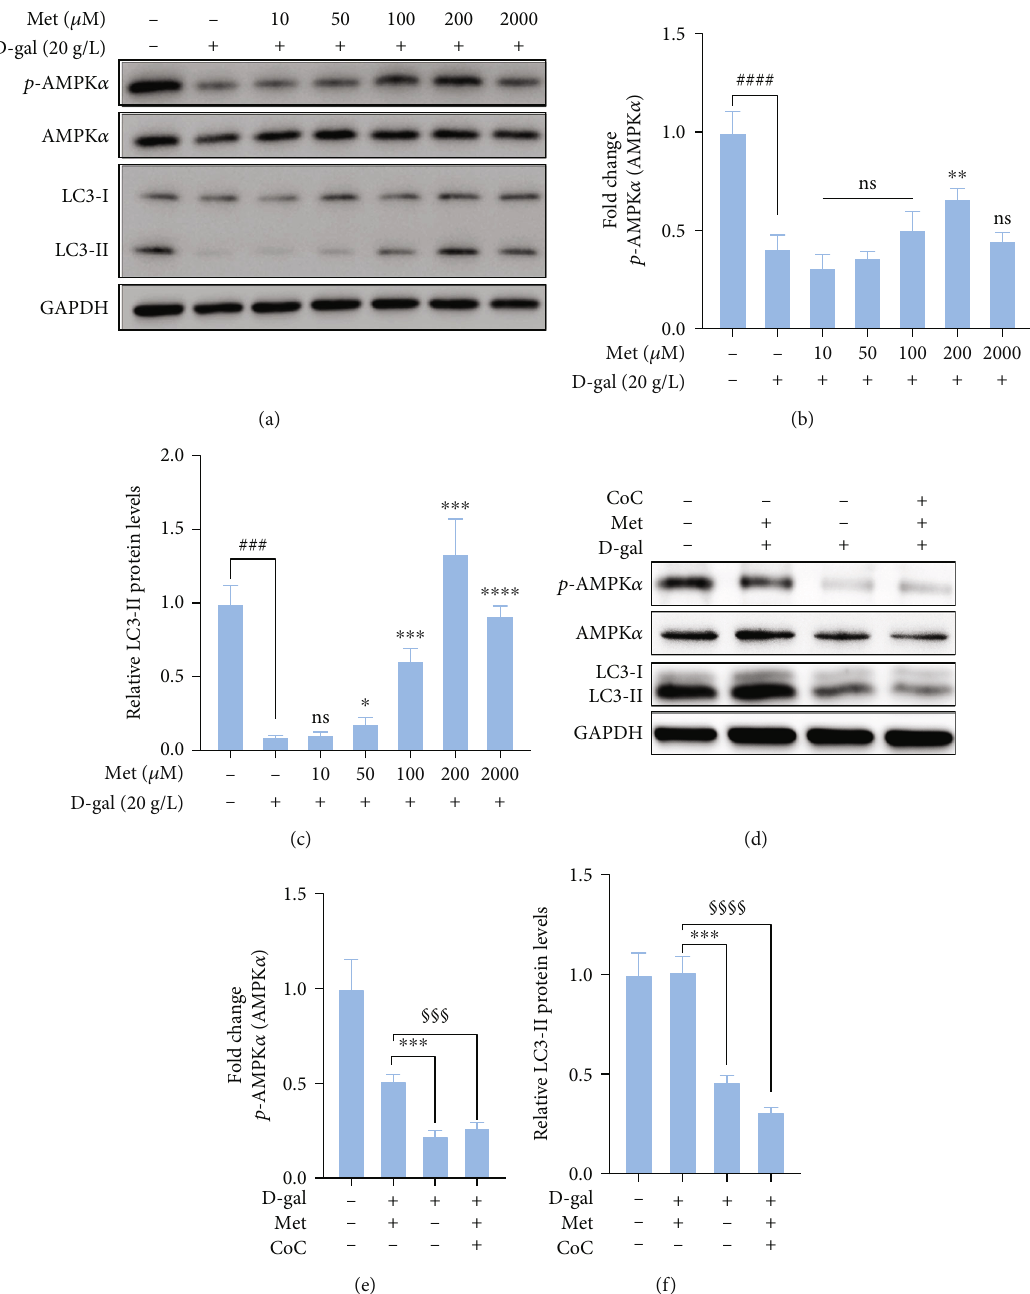
Figure 4: Metformin regulated autophagic fl ux in D-gal-induced hBMSCs by AMPK pathway. (a – c) Western blot analysis of AMPK α , p- AMPK α , and LC3 proteins in hBMSCs treated or not with D-gal or metformin. GAPDH was used as a control. (d – f) Western blot analysis of AMPK α , p-AMPK α , and LC3 proteins in hBMSCs treated or not with 20 g/L D-gal or 200 μ M metformin or 5 μ M CoC. GAPDH was used as a control. n = 3 for each group. Data shown are mean ± SEM . Two-tailed t test. ∗ p < 0 : 05 , ∗∗ p < 0 : 01 , ∗∗∗ p < 0 : 001 , and ∗∗∗∗ p < 0 : 0001 versus the D-gal group; ### p < 0 : 001 and #### p < 0 : 0001 versus the control group; §§§ p < 0 : 001 and §§§§ p < 0 : 0001 versus the D-gal +metformin+CoC group; ns: not signi fi